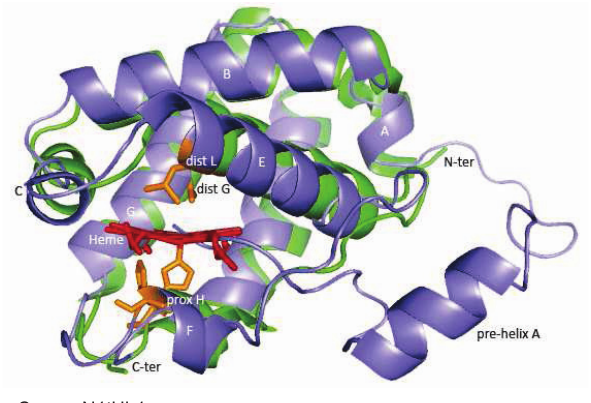
Figure 6. Predicted structure of class 1 CupnecN1tHb1 (blue) overlapped to the structural homologue Tetrahymena pyriformis tHb (PDB ID 3AQ5) (green). Distal and proximal amino acids to the heme Fe are shown in brown; only potential distal E11 is shown in the CupnecN1tHb1 structure. Heme is shown in red. Helices are indicated with letters A to